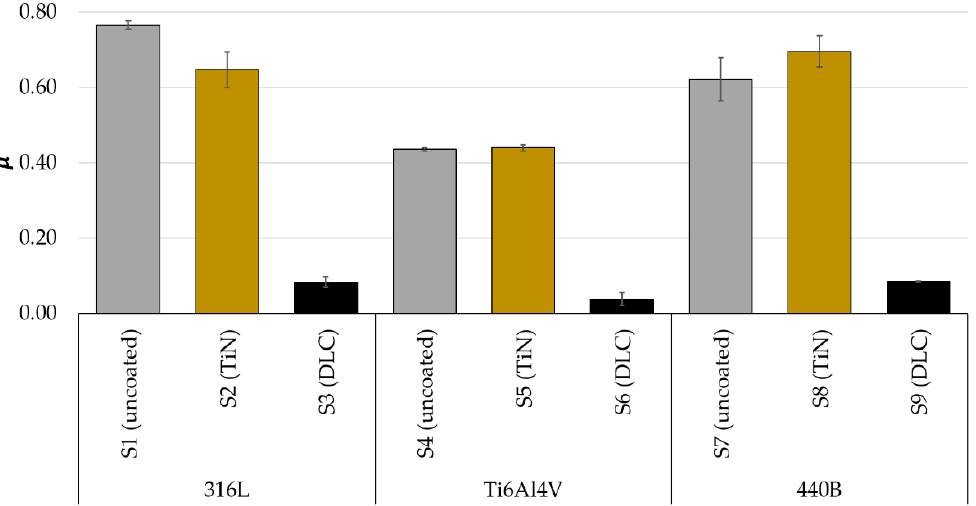
Figure 5. The average values of COF, registered for: 316L austenitic stainless steel, Ti6Al4V titanium alloy, and 440B stainless steel; n = 5 in each sample series.